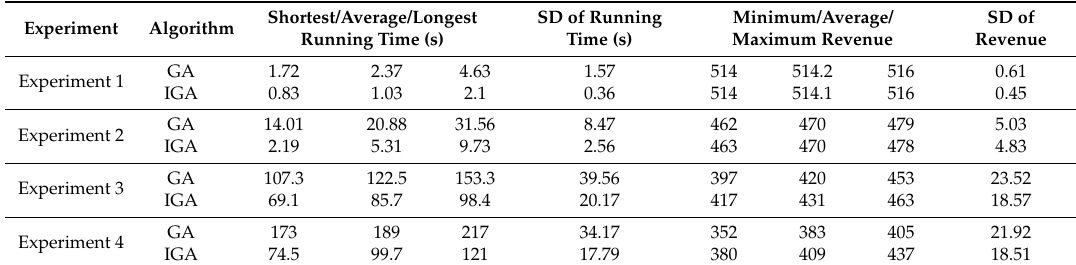
Table 4. The running time and task total revenue of the experiments. SD—standard